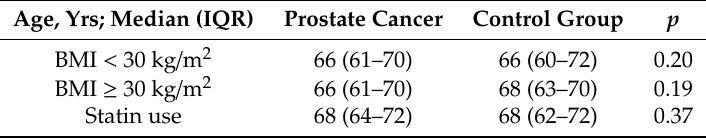
Table 3. Overview of age, categorized per BMI and statin